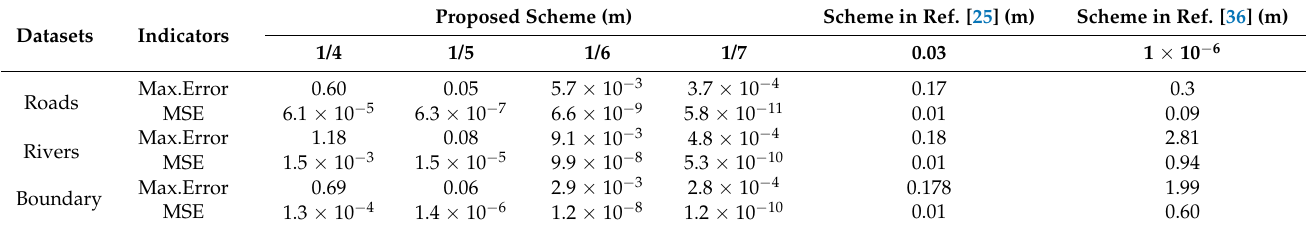
Table 2. Error analysis for the experiment data with different embedding